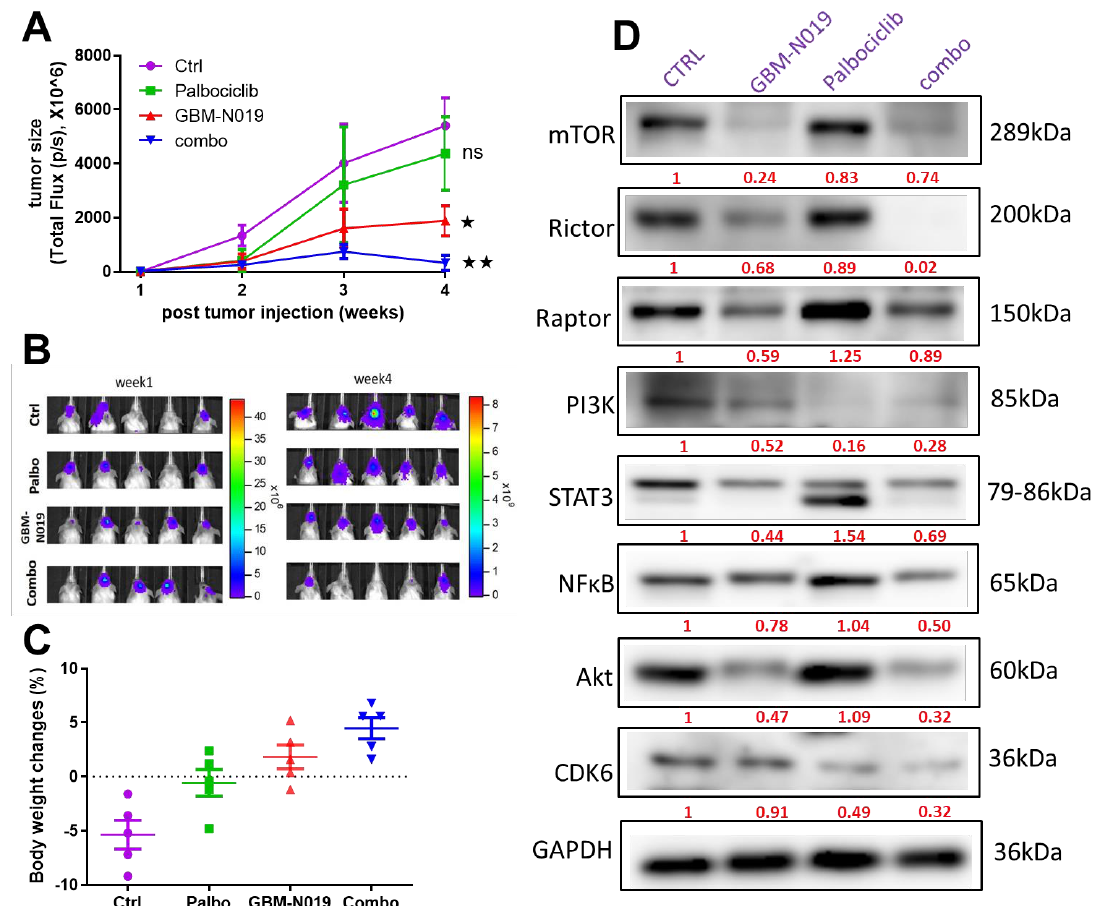
Figure 8. GBM-N019 suppressed U87MG tumorsphere-induced tumorigenesis and enhanced the in vivo efficacy of palbociclib. ( A ) An average tumor volume versus time curve, and ( B ) bioluminescence image shows that treatments with GBM-N019 and palbociclib significantly delayed U87MG tumor growth and burden than GBM-N019 treatment alone. Treatment with palbociclib had no significant therapeutic effect ( p > 0.05) on the tumor progression when compared with the control. ( C ) Graph of percentage body weight changes of mice; GBM-N019 alone or in combination with palbociclib showed a normal body weight gain in the animals over the treatment course, suggesting no apparent systemic toxicity. ( D ) Western blots from tumor samples revealed decreased expressions of mTOR, mTORC1(Raptor), mTORC2(Rictor), PI3K, STAT3, NFkB, Akt, and CDK6 in mice treated with GBM-N019 alone or in combination with palbociclib. Numbers in red indicate the relative expression ratio. * p < 0.05, ** p < 0.01. 4. Discussion The lack of effective therapeutics for managing aggressive phenotypes of GBM ra- tionalized the need to identify therapeutic biomarkers and develop novel bioactive mole- cules with better efficacy and safety profiles than the current standard of care [4–6]. The present study provided evidence that PI3K/Akt/NF-κB/mTOR/STAT3/CDK6 signaling network collectively contributes to generating cancer stemness in GBM. We presented preclinical support of therapeutic intervention GBM-N019 against naïve and aggressive GBM. Our bioinformatics analyses initially suggested that three major oncogenic markers, mTOR, STAT3, and CDK6, are collectively upregulated in GBM and are strongly corre-